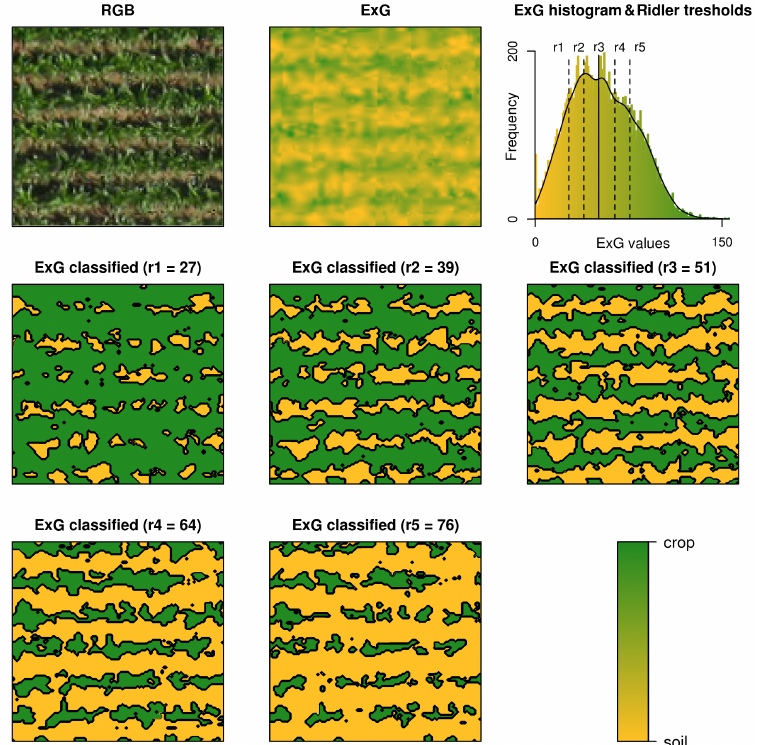
Figure 3. VI-based Ridler thresholding by the example of a 4 × 4 m sub-sample of plot 413 with a sowing density of 11 seeds · m − 2 and nitrogen application of 50 kg · N · ha − 1 . The upper left corner shows the RGB orthoimage, which is displayed at a ground resolution of 0.04 m and at crop growth stage Z39. The second image in the upper row shows the ExG layer, which was derived from the RGB orthoimage. Based on the ExG layer’s histogram, five different thresholds were computed. Threshold r is the original Ridler threshold, whereas 3 the other thresholds represent four variations on the Ridler method (upper right corner). The remaining images show the ExG layer’s classification (green = crop, yellow = soil) based on the five thresholds. In this example, threshold r and r seem to classify best. Thresholds r 3 4 1 and r seem to overestimate crop coverage, while r seems to underestimate crop 2 5